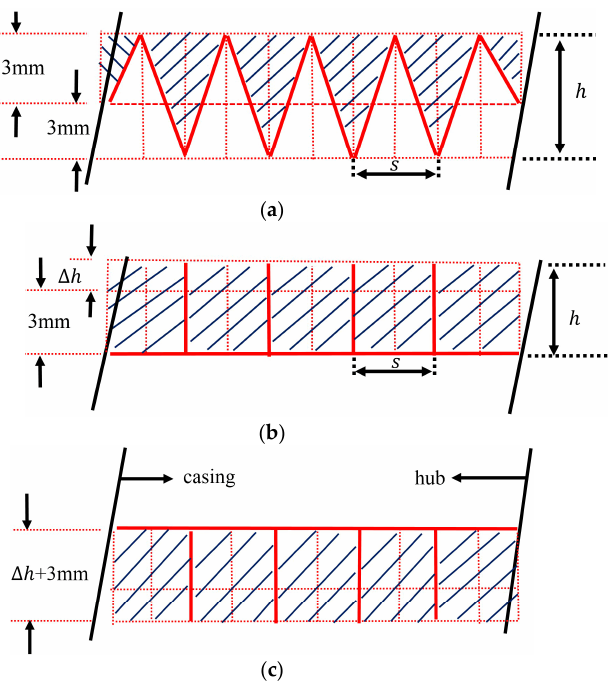
Figure 3. Grooves design illustration, groove number N = 5: ( a ) Wavy shape, ( b ) Riblet shape_ Suction face, ( c ) Riblet shape_ Pressure face. The solid red lines are the blade spanwise sections and the dashed red lines the divide blade cross-section into paths (there are 10 paths). The shade areas of the same N are constant regardless of blade forms which denote the groove cross-section area.